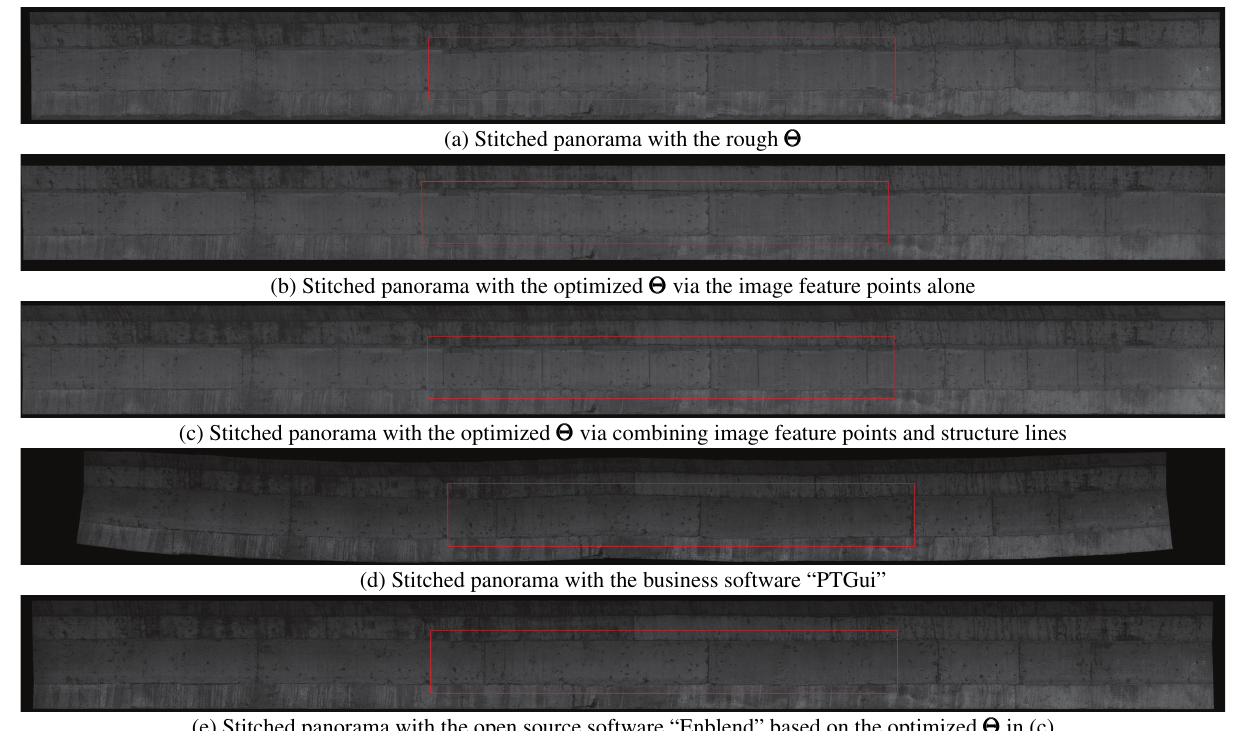
(a) Stitched panorama with the rough (cid:2)(cid:2)(cid:2)